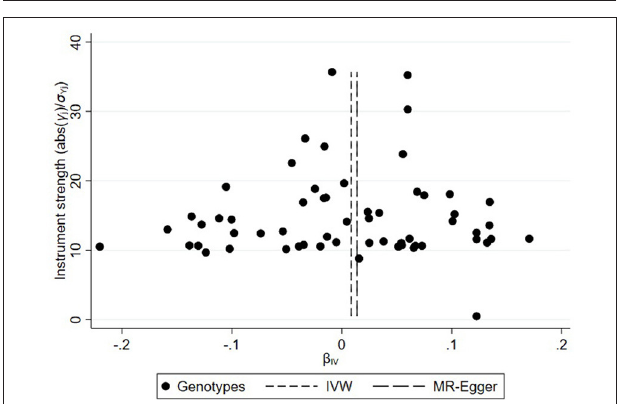
FIGURE 1 | Funnel plot of genetic associations with Crohn’s disease against causal estimates based on each genetic variant individually, where the causal effect is expressed in the log odds ratio of atrial fibrillation for each unit increase in Crohn’s disease. The overall causal estimates ( β coefficients) of Crohn’s disease on atrial fibrillation given by weighted inverse-variance (short dashed line) and MR-Egger (long dashed line) methods are shown.